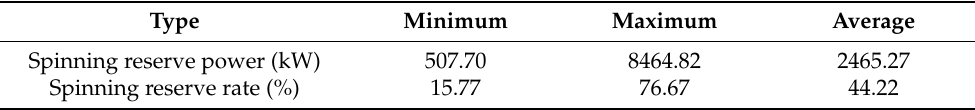
Table 1. Original spinning reserve power and its rate.